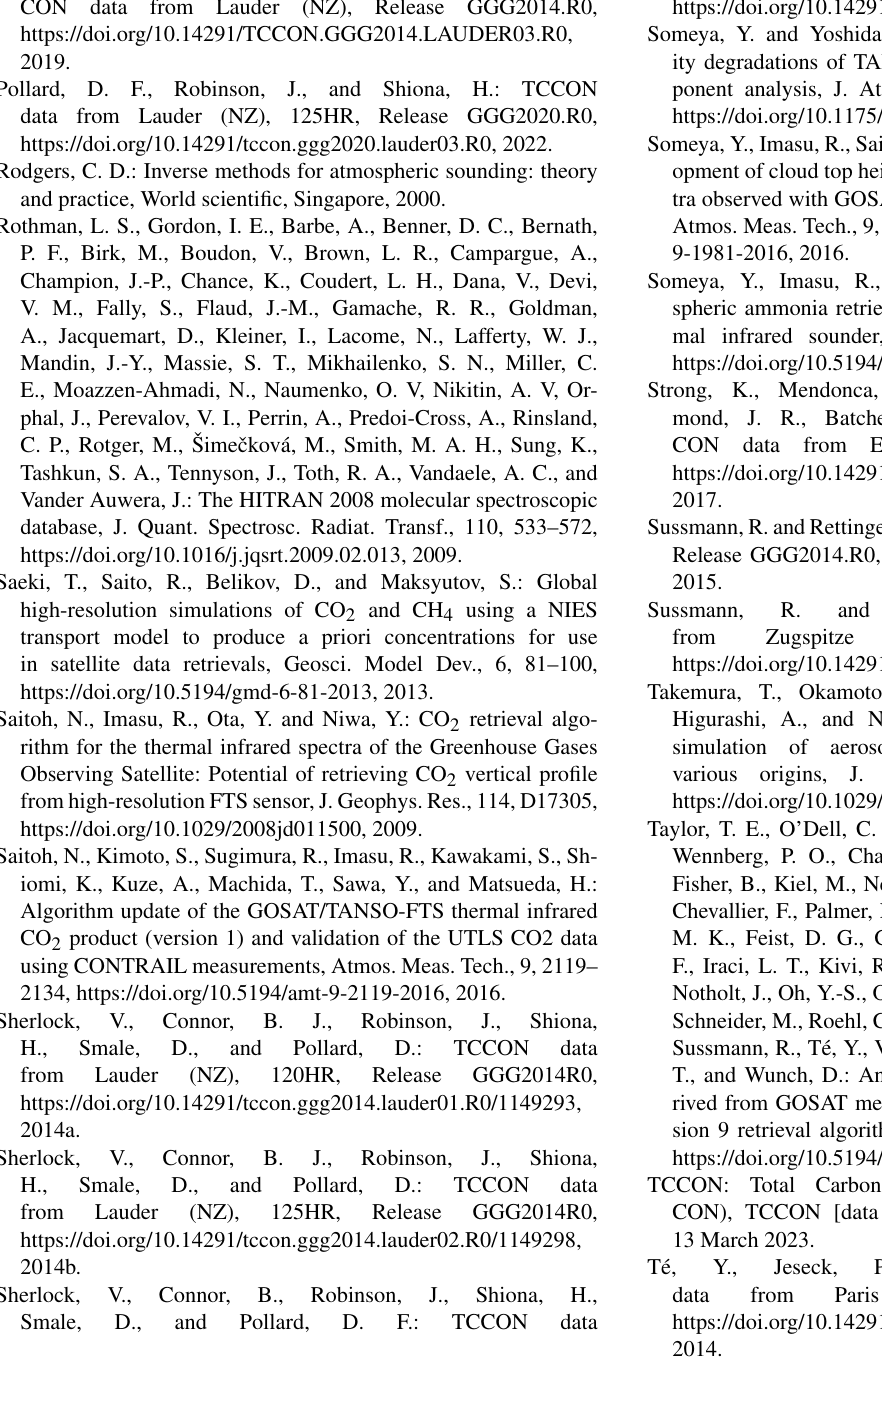
Algorithm update of the GOSAT/TANSO-FTS thermal